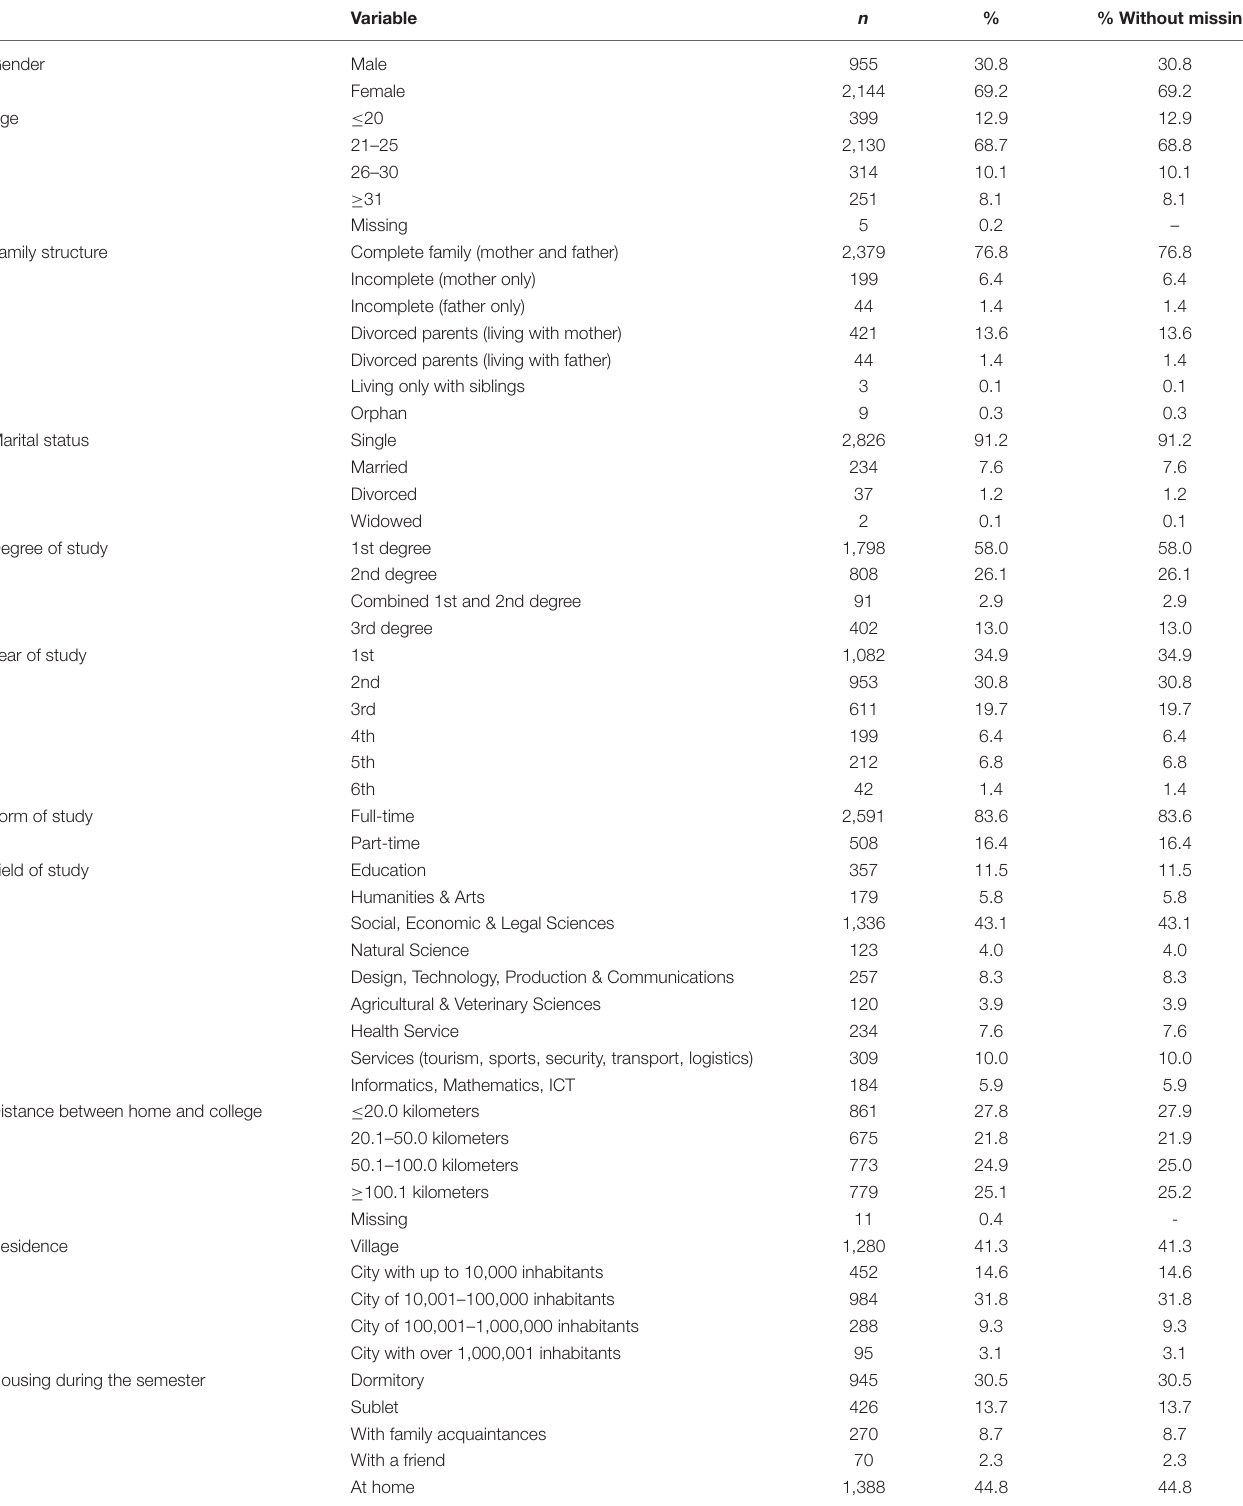
TABLE 1 | Socio-demographic profile of the sample.